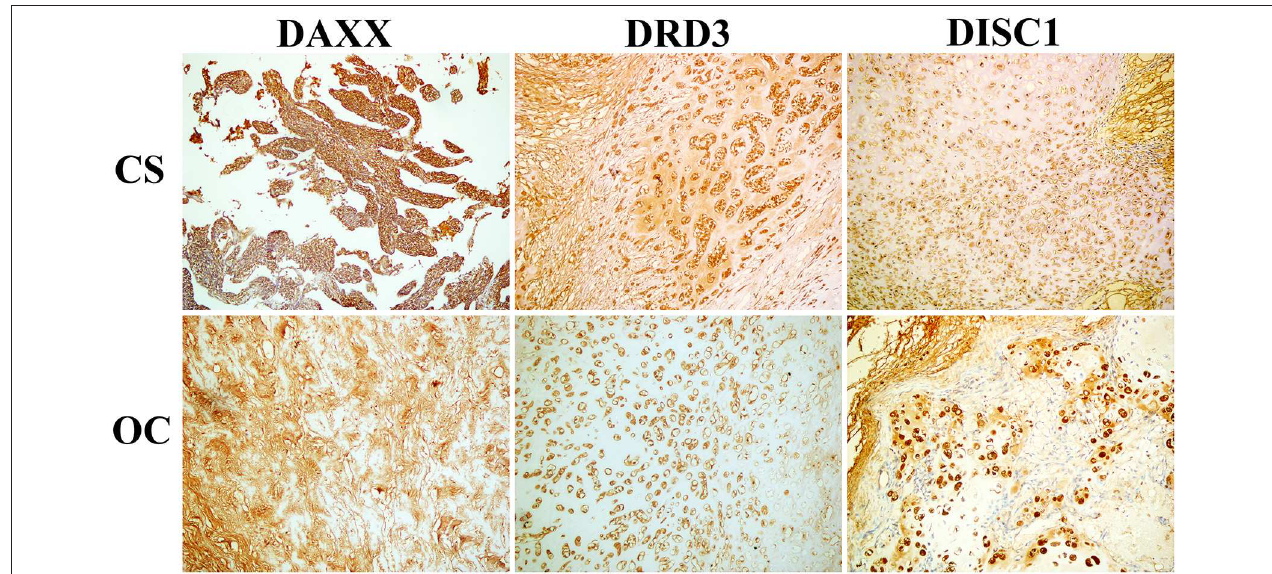
FIGURE 1 | Representative patterns of DAXX, DRD3, and DISC1 expression in chondrosarcoma (CS) and osteochondroma (OC) tissues are shown ( × 200 original magnification).